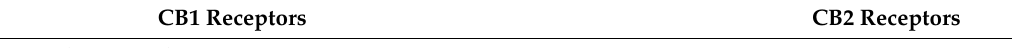
Table 2. Location of CB1 and CB2 Receptors (adapted from